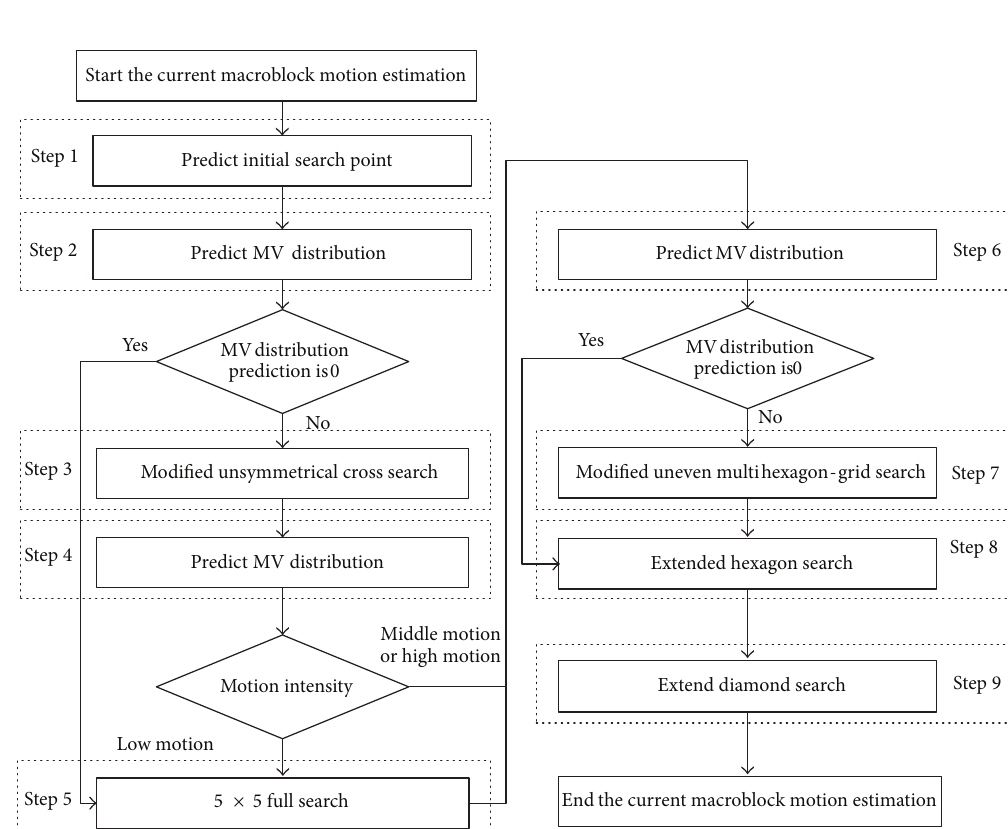
Figure 12: Flow chart of the proposed